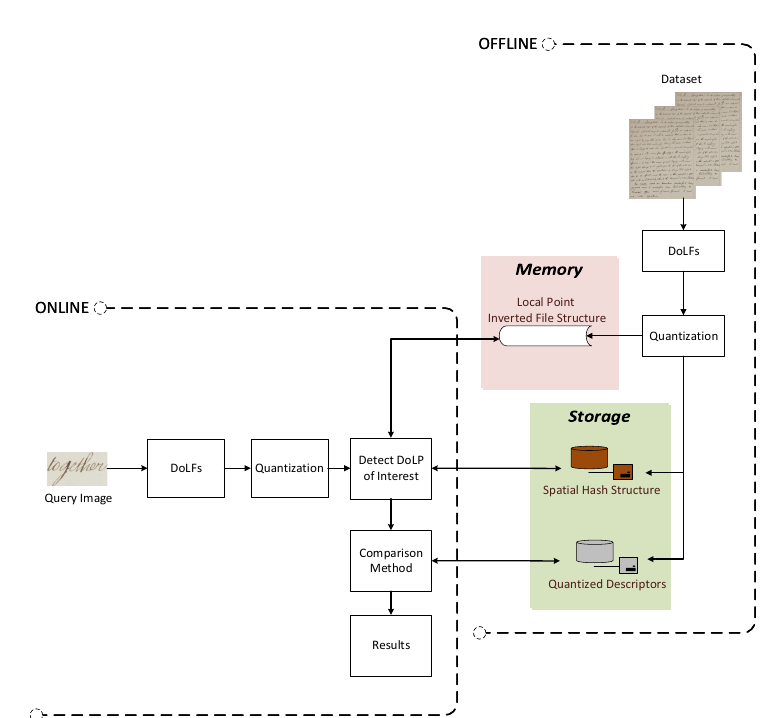
Figure 2. The proposed word spotting architecture. The OFFLINE procedure is only performed once to create the appropriate data structures. The ONLINE process is visible to the user and executes when locating the